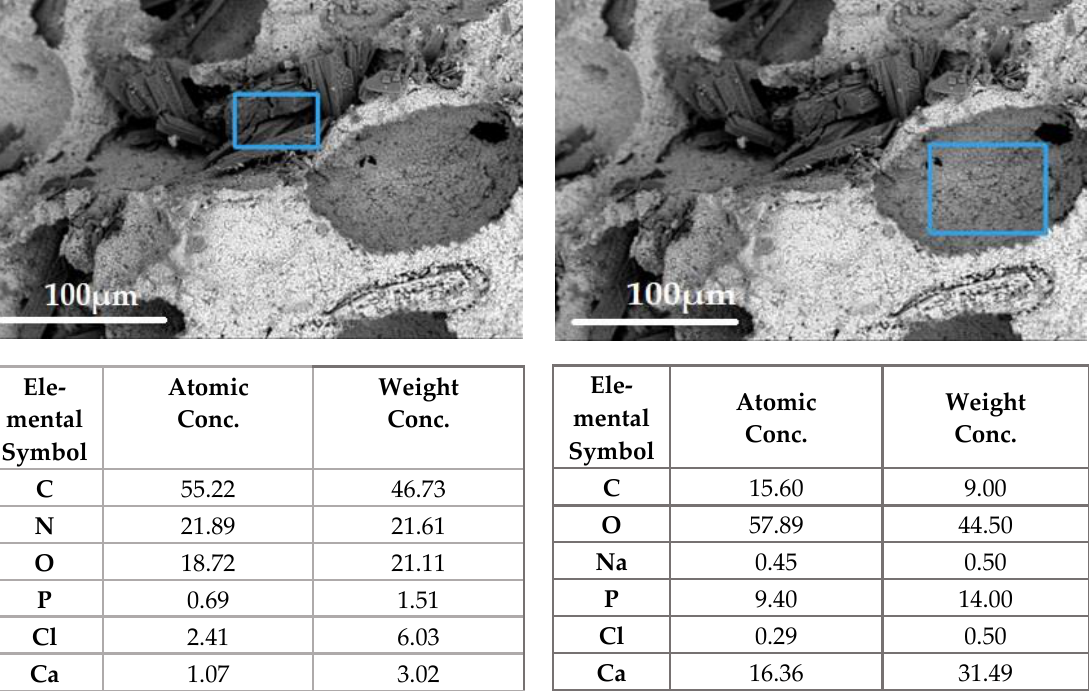
Figure 9. Micrographs of vancomycin: ( a ) initial; ( b ) after interaction with Na 2 HPO 4 ·12H 2 O. Vancomycin inside the matrix was located in the interstitial space in the form of flat crystal accretions, and was absorbed into the calcium phosphate matrix of the ceramics, as confirmed by the data of scanning electron microscopy and energy dispersion analysis (Figure 10).